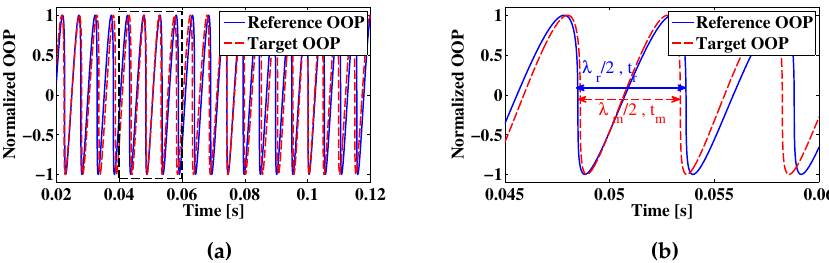
Figure 2. Simulated fringe position change on a measurement signal as a result of a target displacement. The subindex r is used for the reference signal and m for the measurement signal. ( a ) Comparison between a simulated reference OOP (solid line) and a simulated OOP during target displacement(dashed line); ( b ) Zoom around the region inside of the dashed rectangle in ( a ).